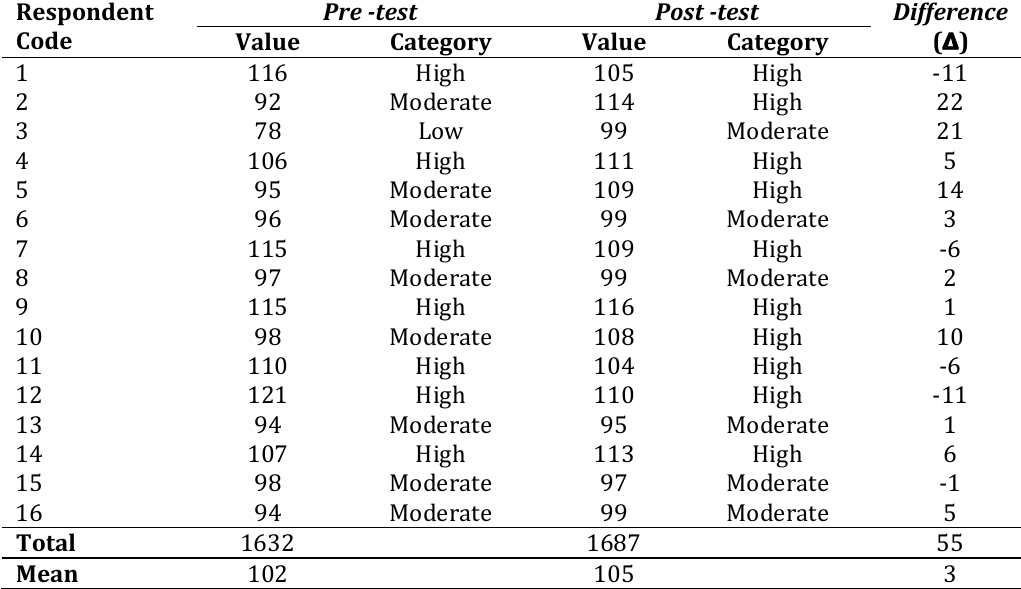
Differences in Quality of Life in the Control Group